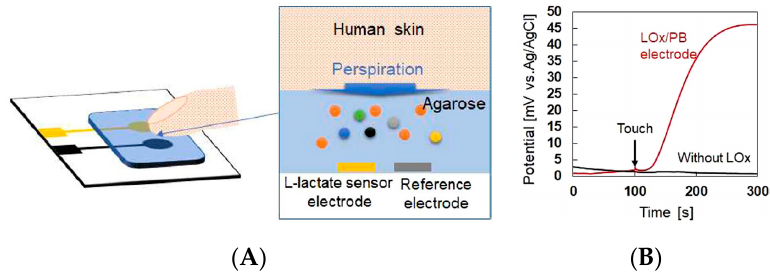
Figure 13. ( A ) View of the agarose-based lactate sensor. ( B ) Potentiometric response of the lactate oxidase modified sensor upon subject’s forefinger contact. Reproduced from [48]. http://creativecommons.org/licenses/by/4.0/.